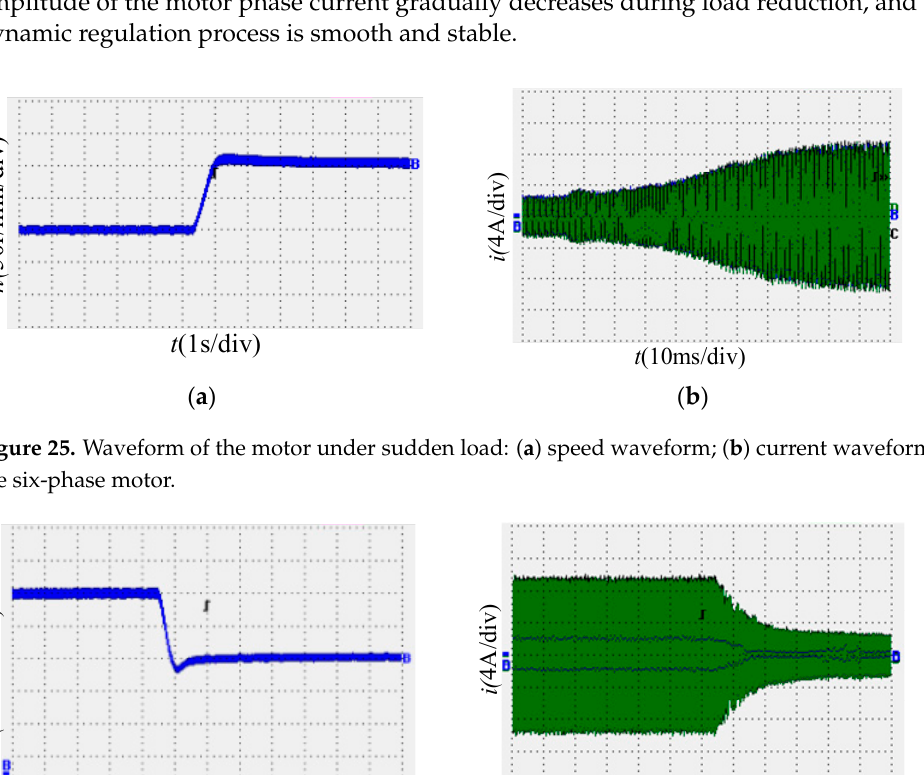
Figure 24. Waveform of motor under stable operation at 500r/min: ( a ) current waveform of phase a , b , and c ; ( b ) current waveform of phase a , b , and d .